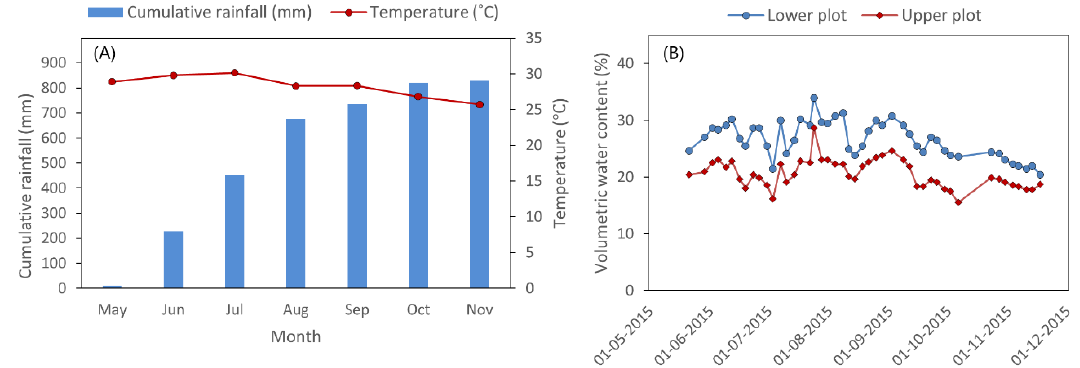
Figure 4. Graphs showing ( A ) monthly mean temperature and cumulative rainfall distributions, and ( B ) volumetric water contents throughout the entire growing season (mid-May to mid-November) of the researcher-managed field trial.